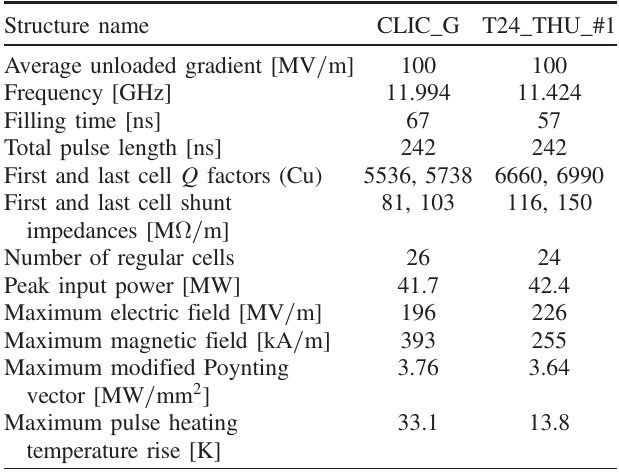
Fig. 1. Diffusion bonding of the main cell stack was